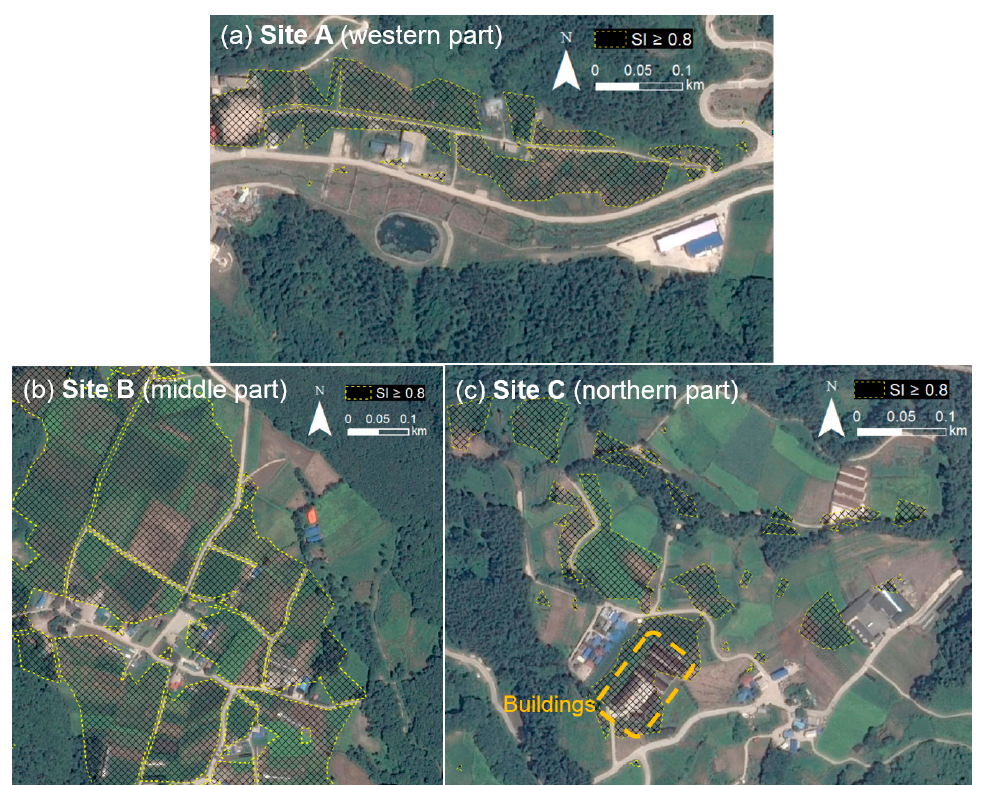
Figure 6. Sensitivity analysis of the SI results for PV solar farm development: ( a ) Case 1: Even weight for all factor variables; ( b ) Case 2: Only solar PV energy production factors (solar irradiation, sunshine hours, average daily temperature in summer); ( c ) Case 3: Only natural environmental factors (excluding proximity to grid connection and proximity to road) and ( d ) Case 4: All factors except slope factor.